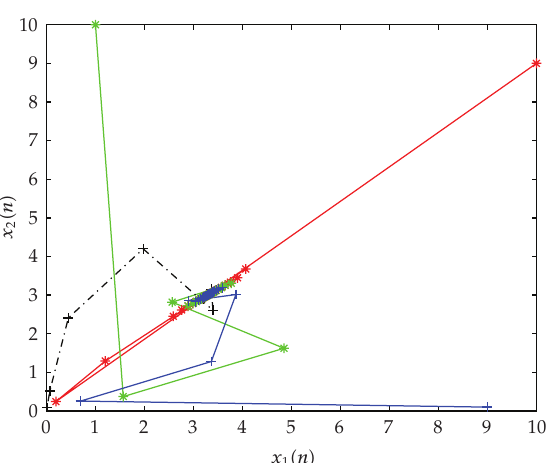
Figure 1: Solutions of system (cid:3) 1.1 (cid:4) with initial values (cid:3) x 1 (cid:3) 0 (cid:4) ,x 2 (cid:3) 0 (cid:4)(cid:4) (cid:5)(cid:3) 10,9 (cid:4) , (cid:3) 1,10 (cid:4) , (cid:3) 0.01,0.09 (cid:4) , (cid:3) 9,0.1 (cid:4) , and r 1 (cid:5) 1 . 95 ,r 2 (cid:5) 1 . 8.